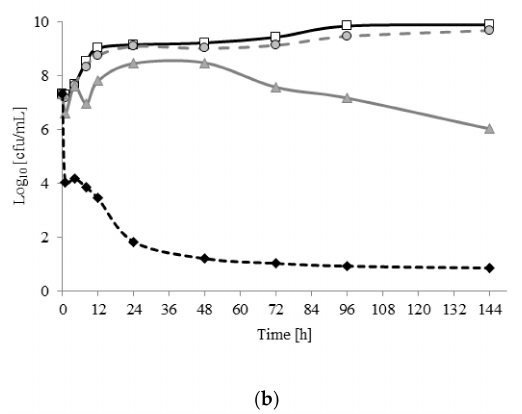
Figure 1. The growth of A. lannensis FMW1 in medium with microbiocides ( a ) hexamethylene- 1,6-bis-( N,N -dimethyl- N -dodecylammonium bromide) (C6) and ( b ) N -dodecyltrimethylammonium bromide (DTAB). The results are presented after cells treatment by surfactants in the concentration 1 / 4 minimal inhibitory concentration (MIC) (dark grey circle marker), 1 / 2 MIC (clear grey triangle marker), MIC (black rhombus marker), and compared with the control sample -without the addition of surfactants (white square marker).